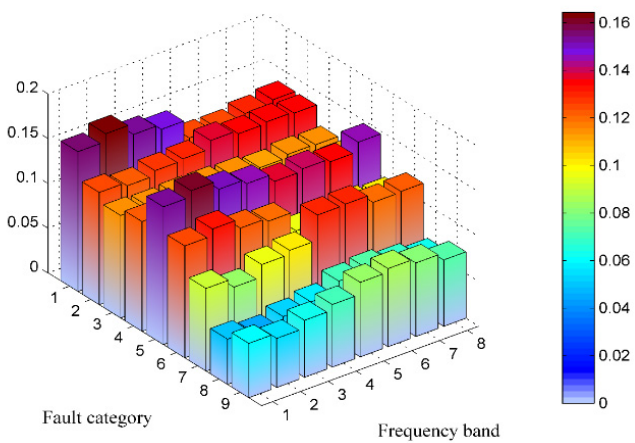
Figure 16. Normalized fault features.